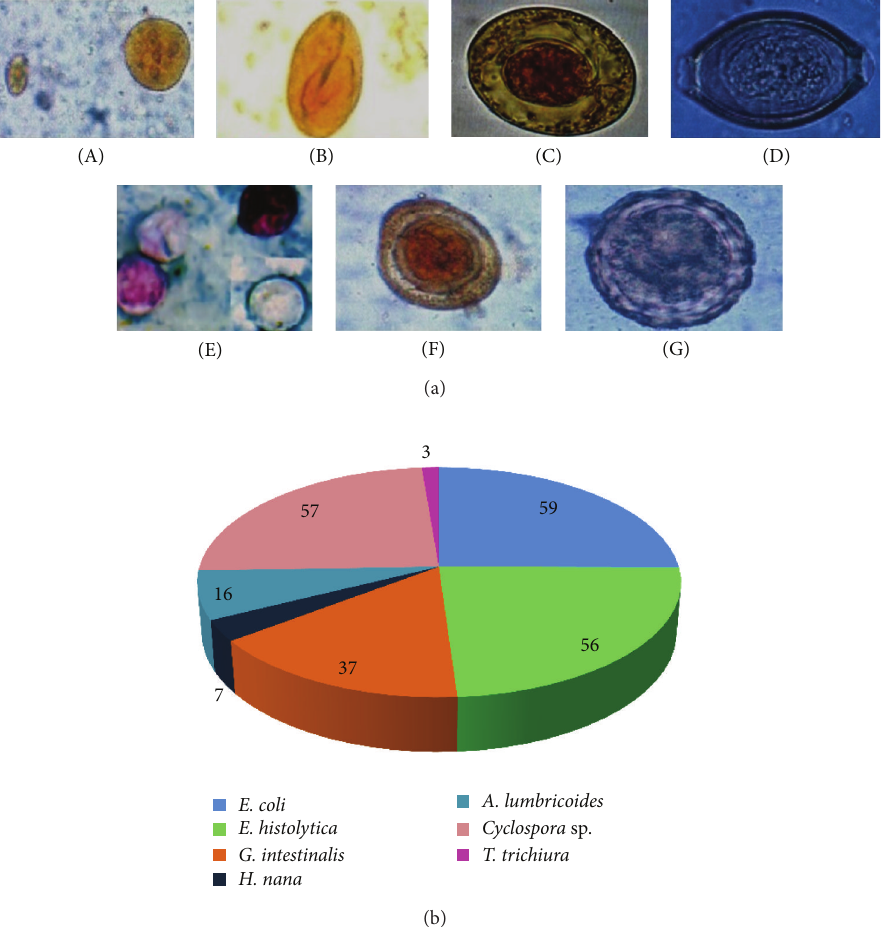
Figure 1: Parasites identified from stool samples. (a) Microscopic observation of protists and eggs (A) Entamoeba coli; (B) Giardia intestinalis; (C) Hymenolepis nana; (D) Trichuris trichiura; (E) Cyclospora sp. (F) Ascaris lumbricoides —decorticated egg; (G) A. lumbricoides —corticated egg. (b) Distribution of parasites in pie